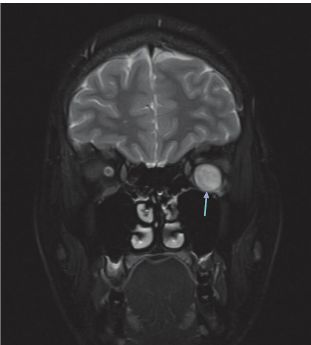
Figure 5: Coronal T2 weighted MR image showing hyperintense haematoma (arrow).